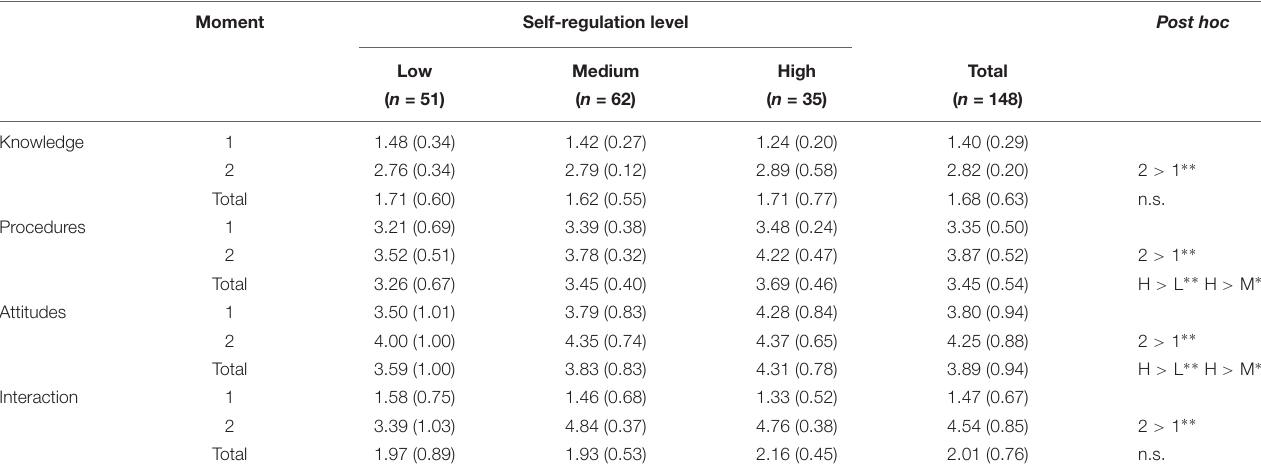
TABLE 3 | Effect of the e-ALADO utility in interaction with students’ level of